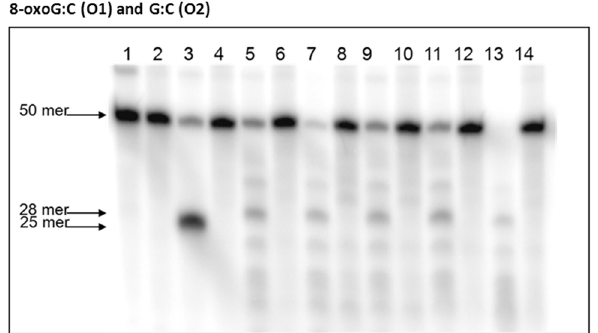
Figure 7. 8-oxoG removal activities of cell extracts from P. gingivalis strains W83 and isogenic mutants. [ c - 32 P]-ATP-5 9 -end- labeled oligonucleotides (O1 and O2) were incubated with P. gingivalis extracts for 10 min, electrophoresed and visualized. Lane 1 contained O1; Lane 2 contained O2; Lane 3 contained O1 and Fpg enzyme; Lane 4 contained O2 and Fpg enzyme; Lane 5 contained O1 and P. gingivalis W83 extract; Lane 6 contained O2 and P. gingivalis W83 extract; Lane 7 contained O1 and P. gingivalis FLL145 extract; Lane 8 contained O2 and Figure 8. 8-oxoG removal activities of Fpg enzyme. [ c - 32 P]-ATP-